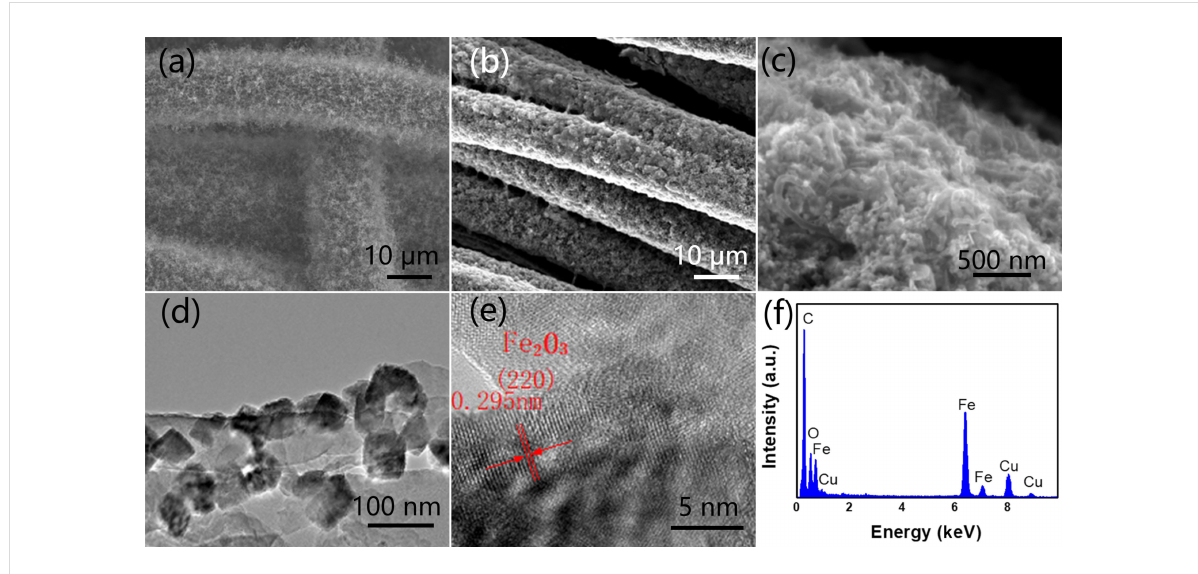
Figure 2: SEM images of (a) CNTs grown on carbon cloth; (b) CC-CNT@Fe 2 O 3 ; (c) magnified CC-CNT@Fe 2 O 3 . (d) TEM image of Fe 2 O 3 particles with a diameter of 50 nm on CNT. (e) High-resolution TEM image of Fe 2 O 3 with an interplanar spacing of 0.295 nm, corresponding to the (220) plane of Fe 2 O 3 . (f) EDX spectrum of the CC-CNT@Fe 2 O 3